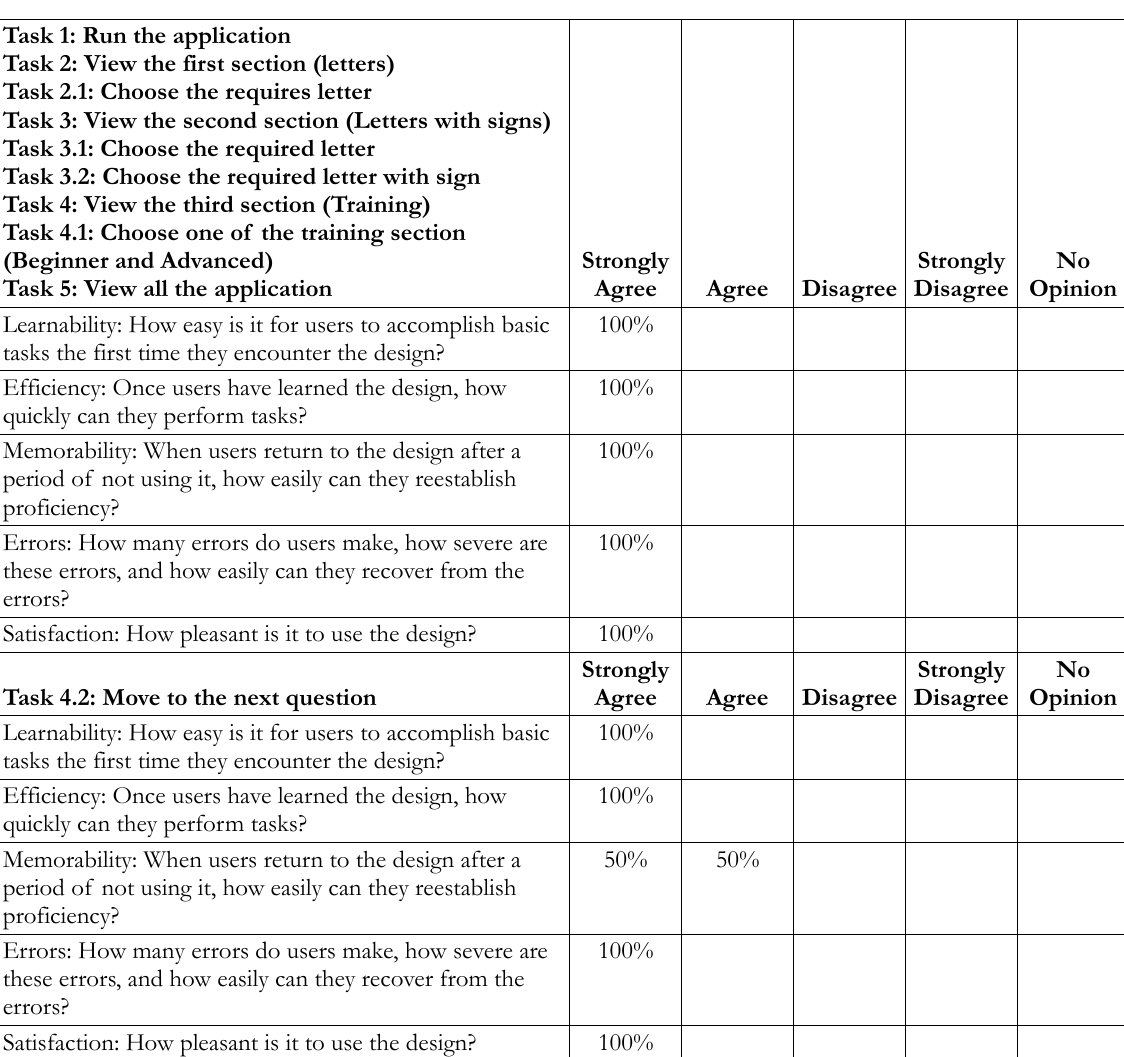
Table 3. The results of the pre-test questionnaire for each